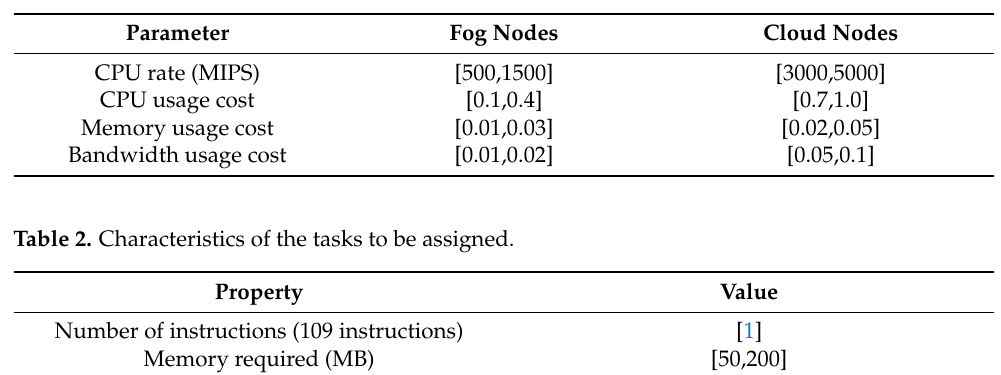
Table 1. Characteristics of the nodes in a cloud-fog computing environment.